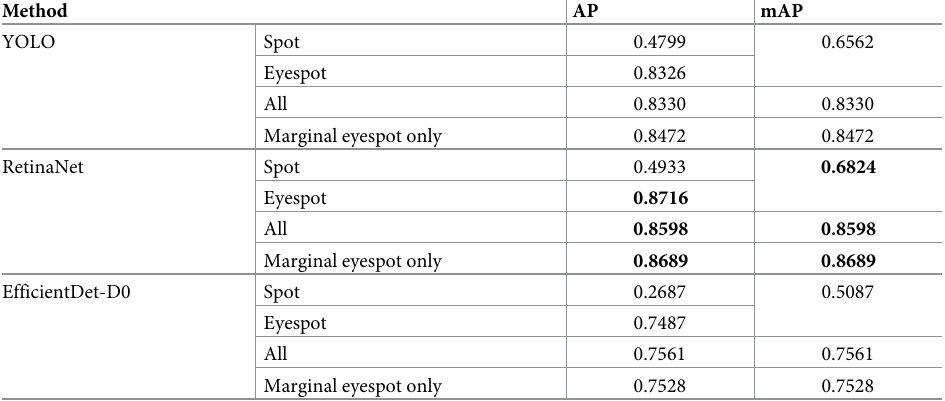
Table 2. Scores achieved by YOLO, RetinaNet and EfficienDet-D0 models for the three eyespot detection tasks on the test data from dataset1.